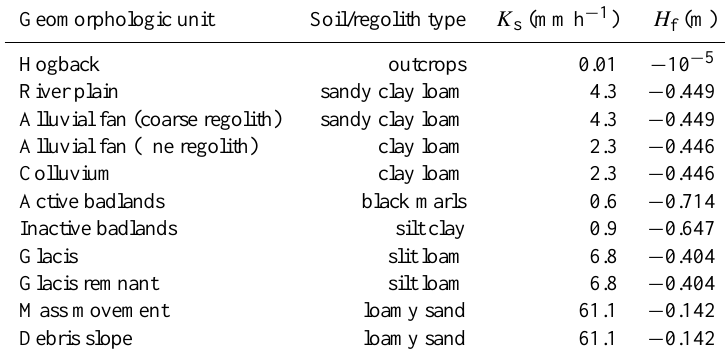
Table 4. Soil texture and corresponding soil hydraulic parameters ( K s and H f ) estimated for each type of geomorphologic unit (Rawls et al.,